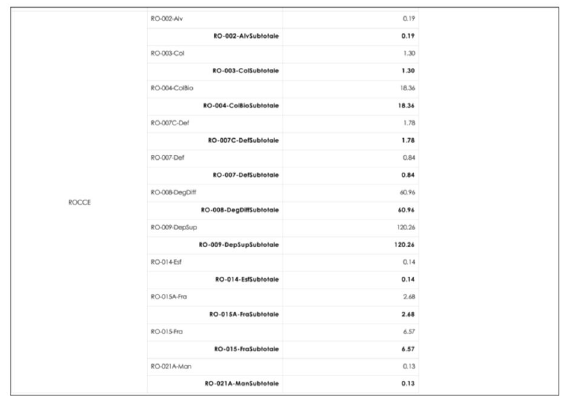
Figure 11. Portion of a PDF report automatically generated by EasyCUBE PRO (computational